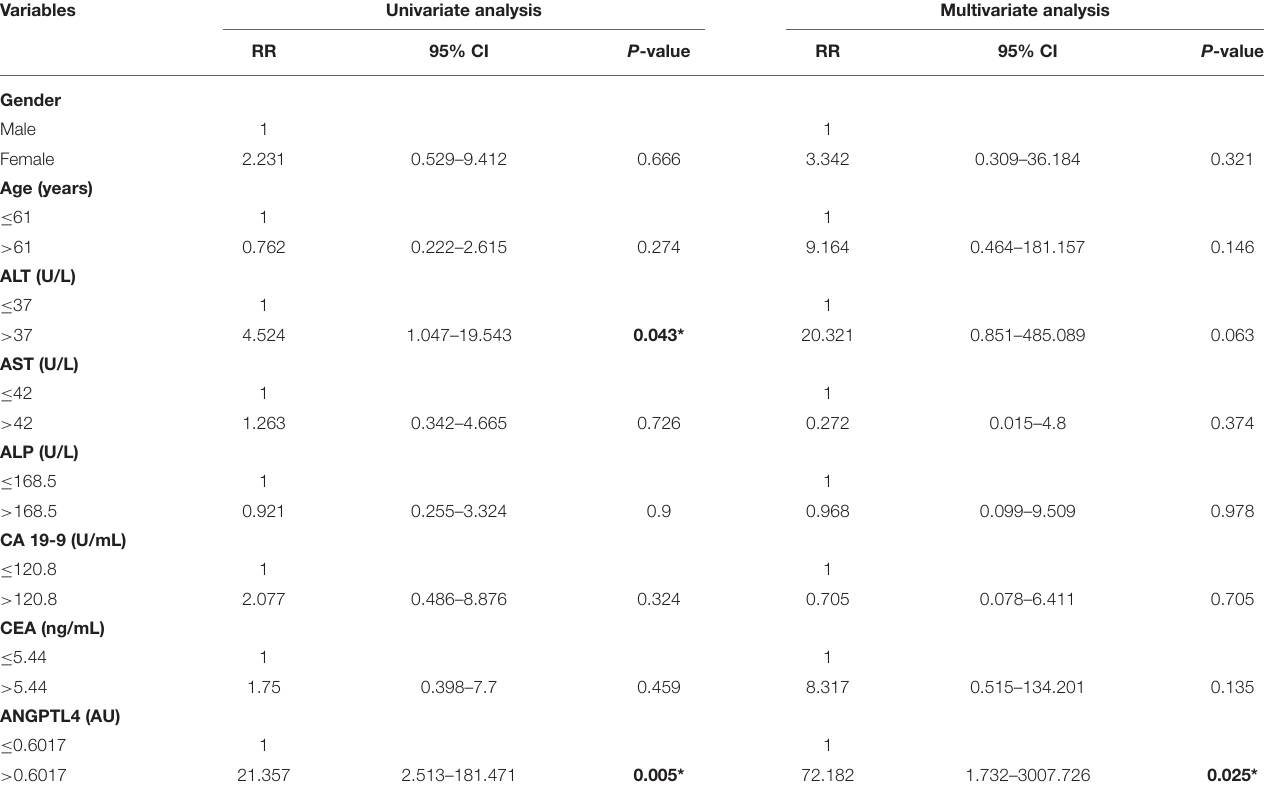
TABLE 4 | Univariate and multivariate regression analysis of clinical parameters associated with vascular invasion.